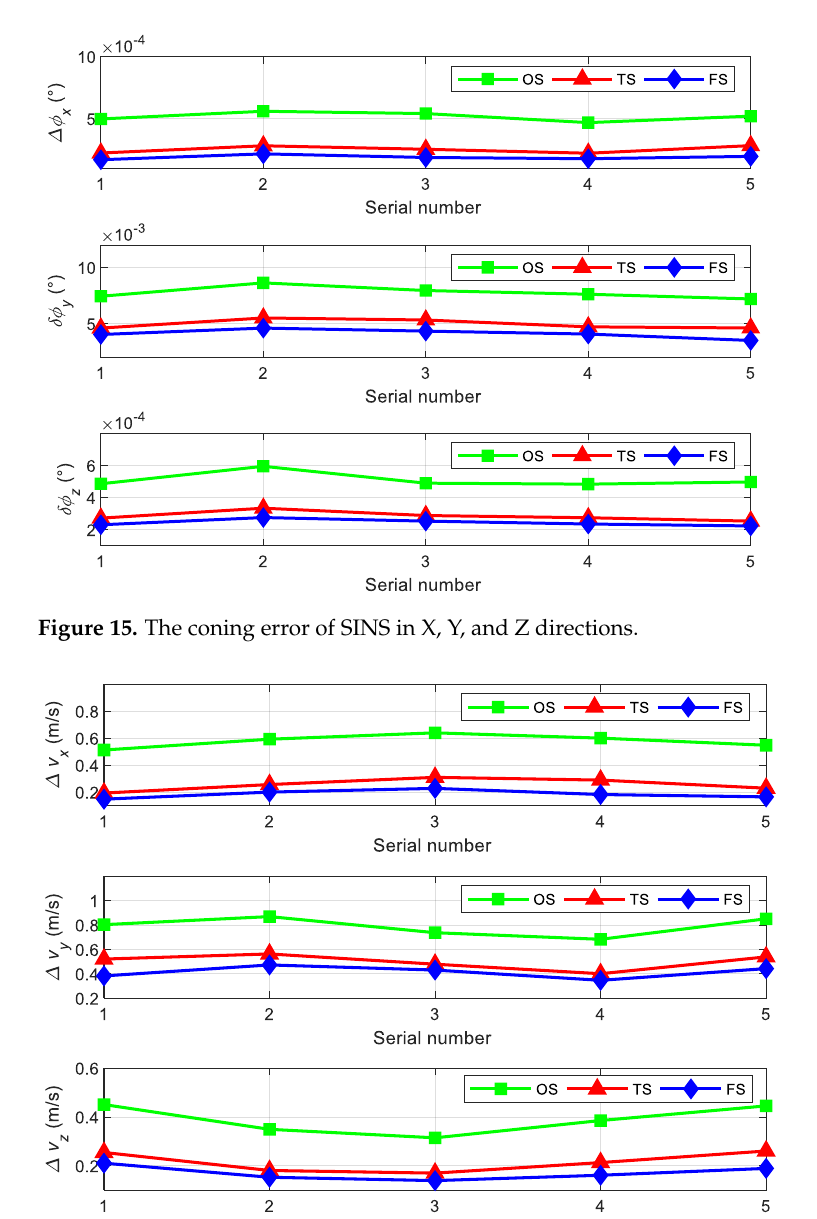
Figure 16. The sculling error of SINS in X, Y, and Z directions.